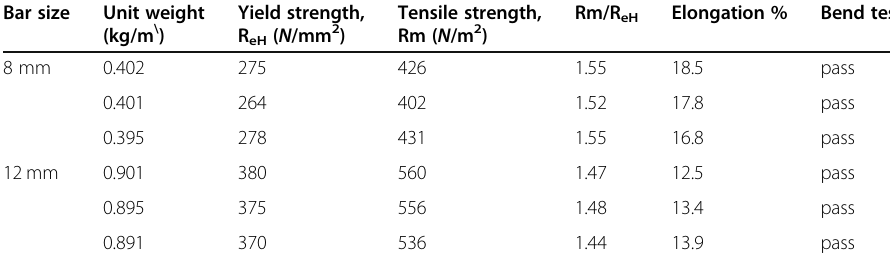
Table 4 Mechanical properties of steel reinforcement bars Bar